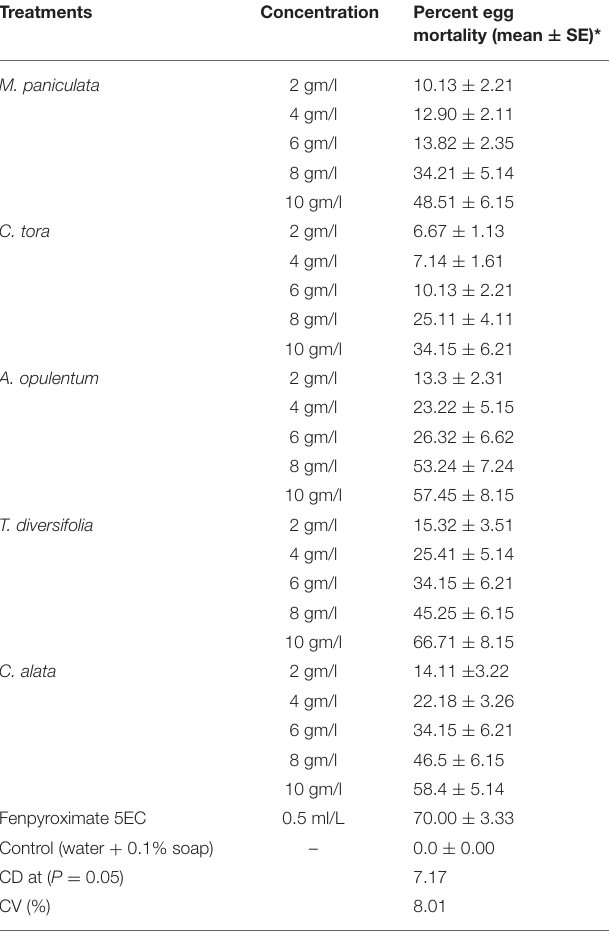
TABLE 2 | Ovicidal action of pesticidal plant extracts on eggs of the tea red spider mite. Treatments Concentration Percent egg